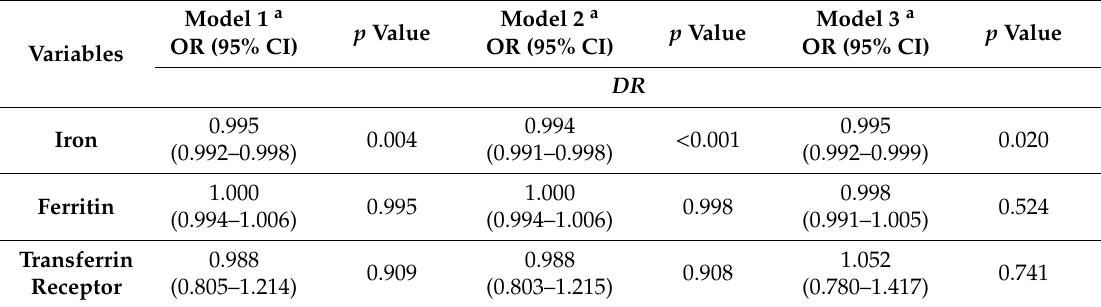
Table 3. Association between iron, ferritin, transferrin receptor, and the presence of DR.